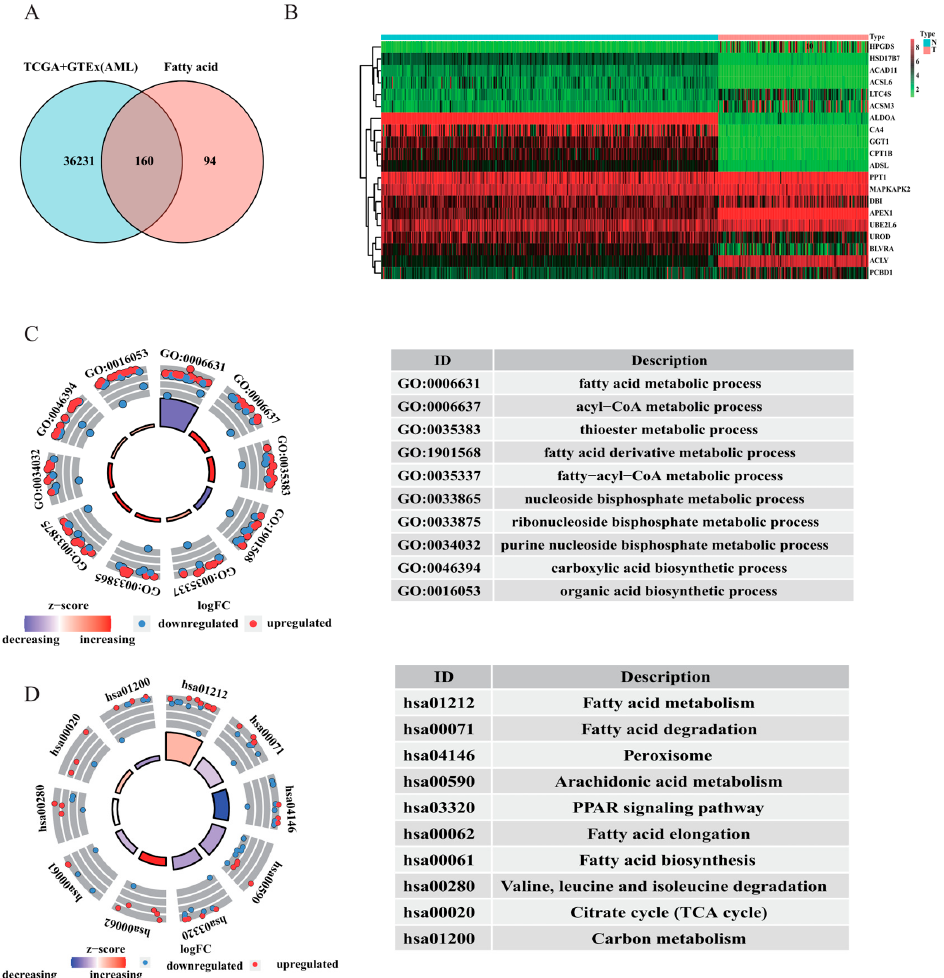
Figure 2. Comparison between AML and normal samples in the TCGA and GTEx databases. ( A ) Venn diagram of FAM-related genes in this study. ( B ) Heatmap of the top 10 upregulated and downregulated FAM-related DEGs in AML and normal samples. ( C , D ) GO and KEGG pathway analyses of DEGs related to fatty acid metabolism in AML and normal samples.